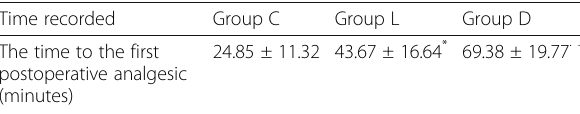
Table 6 The time to the first postoperative analgesic (mean ± standard